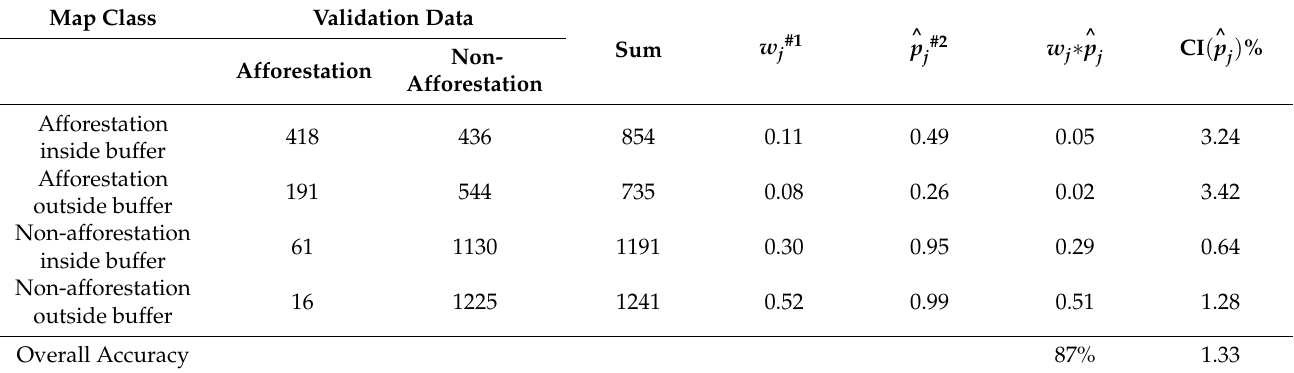
Table A1. Overall and per-class accuracies assessment for the direct map. Results of Table 2 calculations.